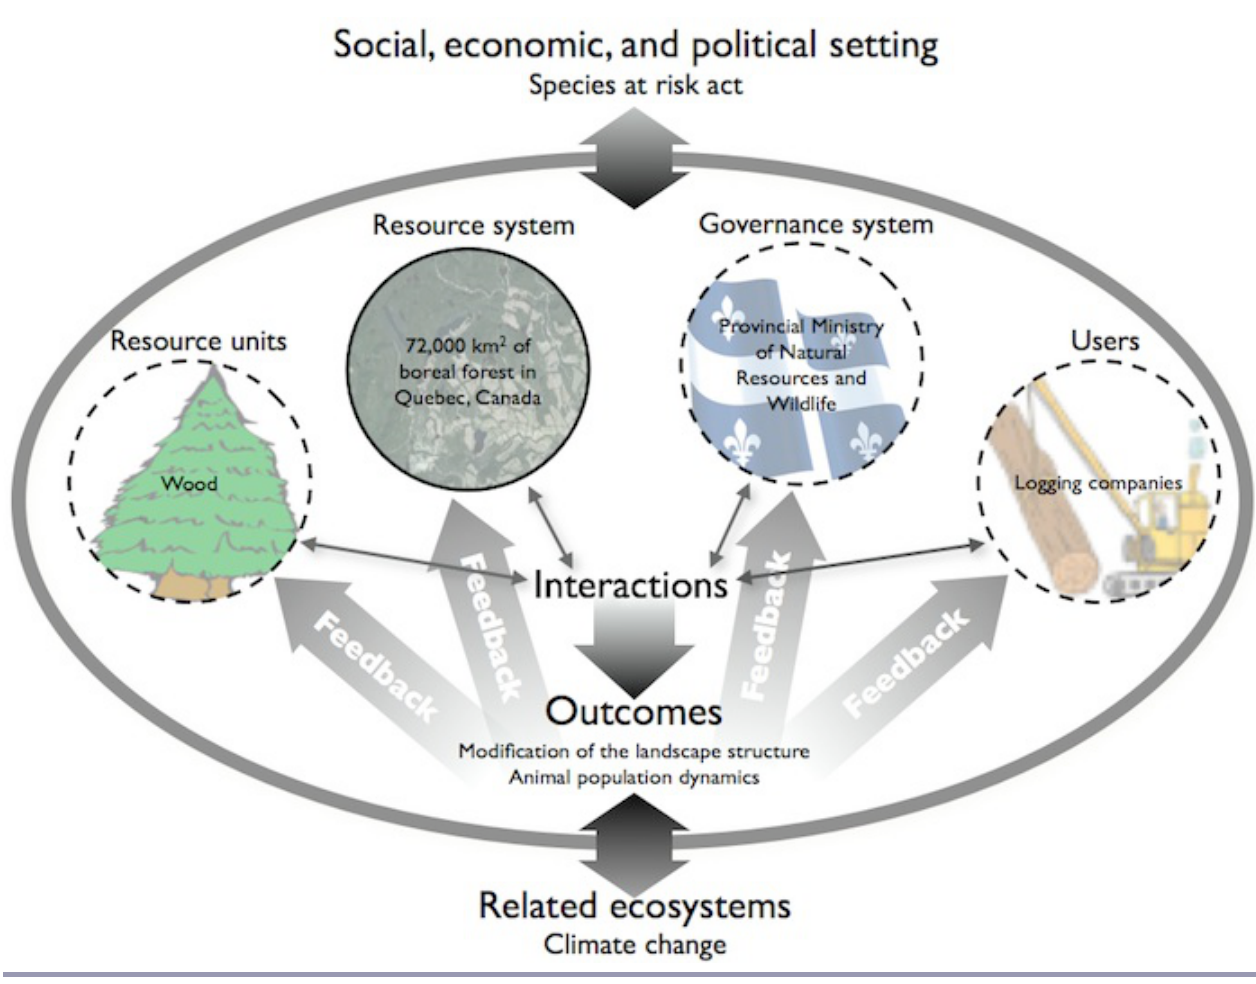
Fig. 4 . Conceptual diagram showing the main components and interactions of the boreal forest social-ecological system, based on Ostrom’s framework (Ostrom 2009). The dashed lines encircle parts of the system that are not explicitly included in the